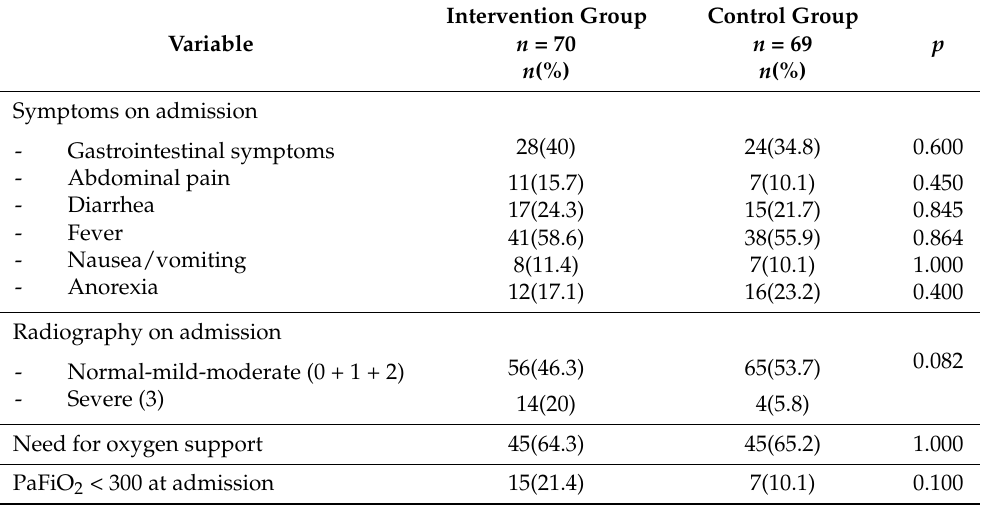
Table 2. Summary of the clinical and radiographic characteristics of the study population at admission. The p -values were obtained with the X 2